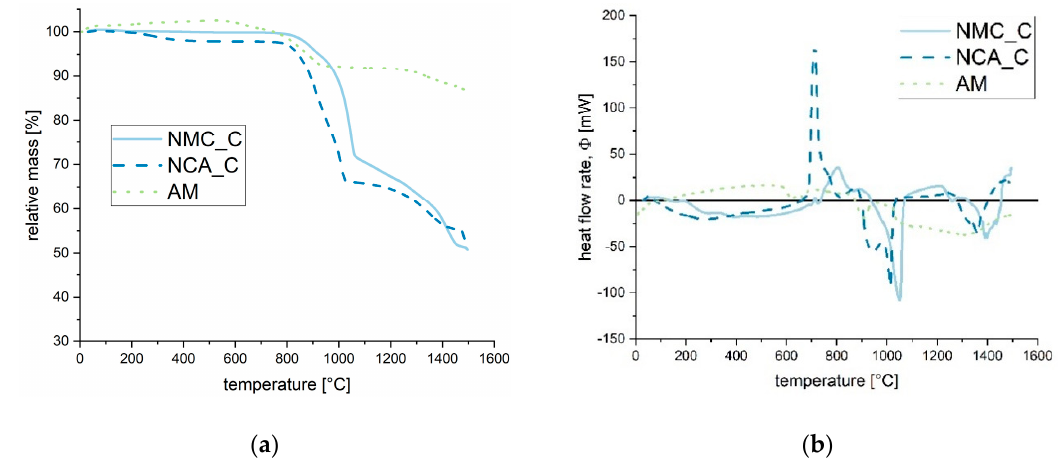
Figure 6. Results of the simultaneous thermal analyses of NMC_C and NCA_C with a heating rate of 40 K/min. ( a ) Trend of the relative mass of NMC_C and NCA_C during heating. ( b ) Trend of the heat flow of NMC_C and NCA_C during heating.